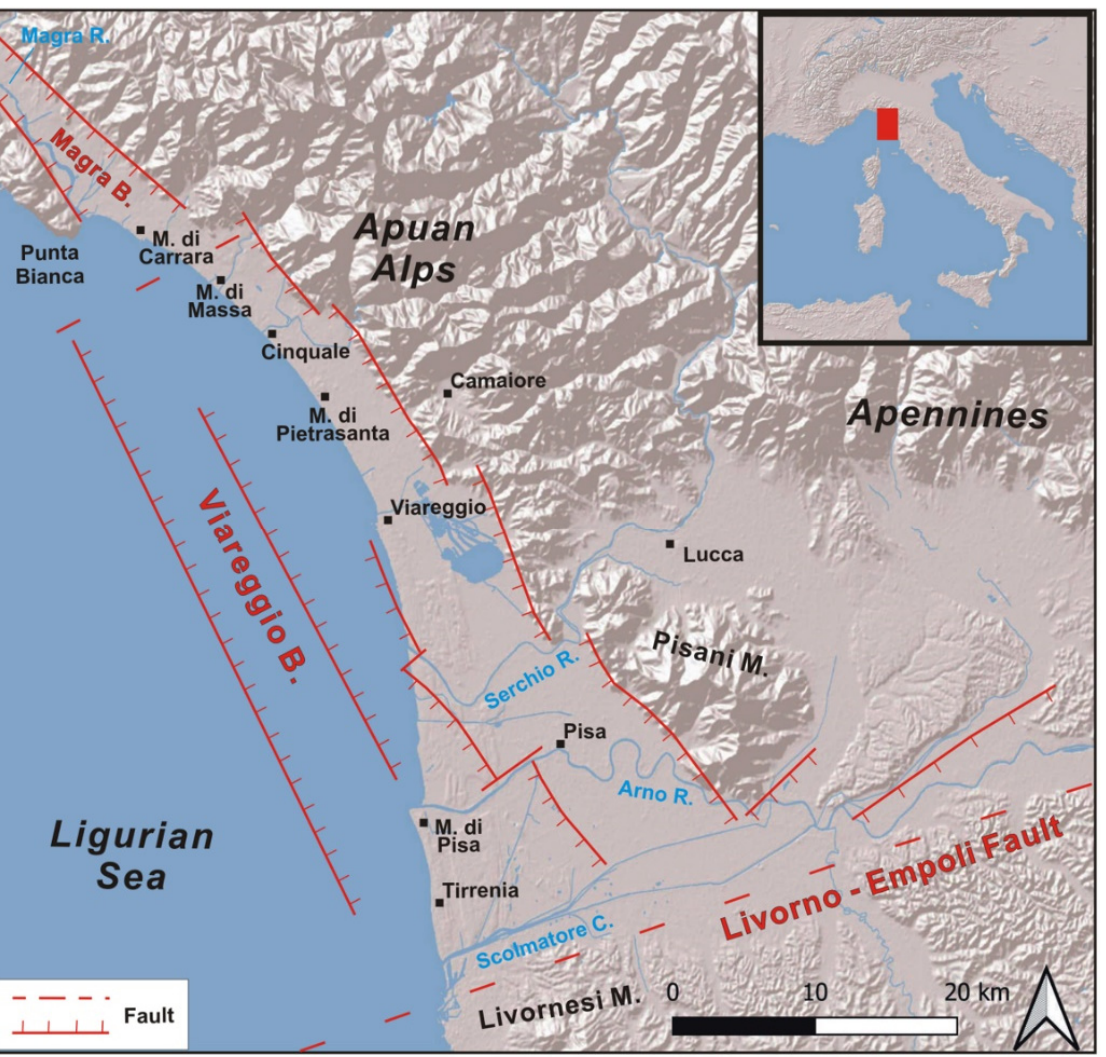
Figure 1. Map of the study area (northern Tuscany, Italy). Red lines correspond to the most significant geological features, such as faults. Basemap: ESRI Shaded Relief, available on QGIS QuickMap Services. Redrawn after [26].